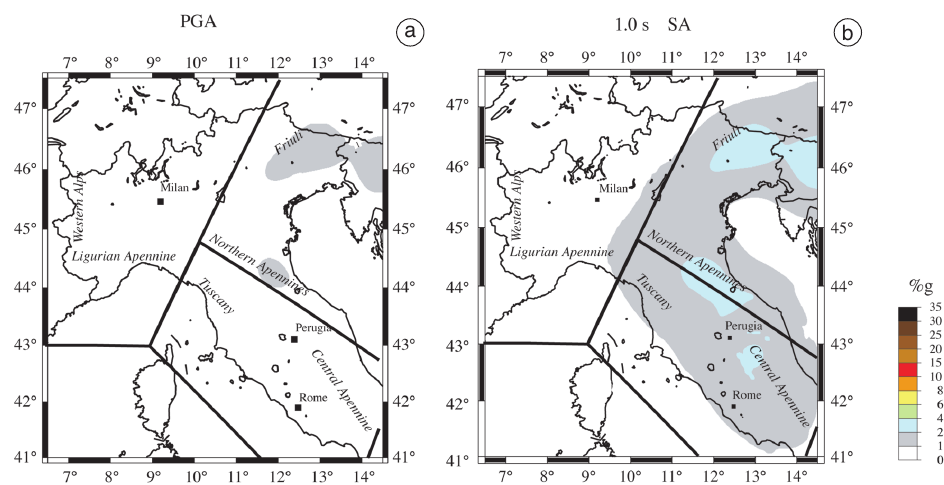
Fig. 8a,b. Parameter 95% confidence band map in Northern and Central Italy for maximum magnitude, a) PGA and b) 1-Hz spectral acceleration.